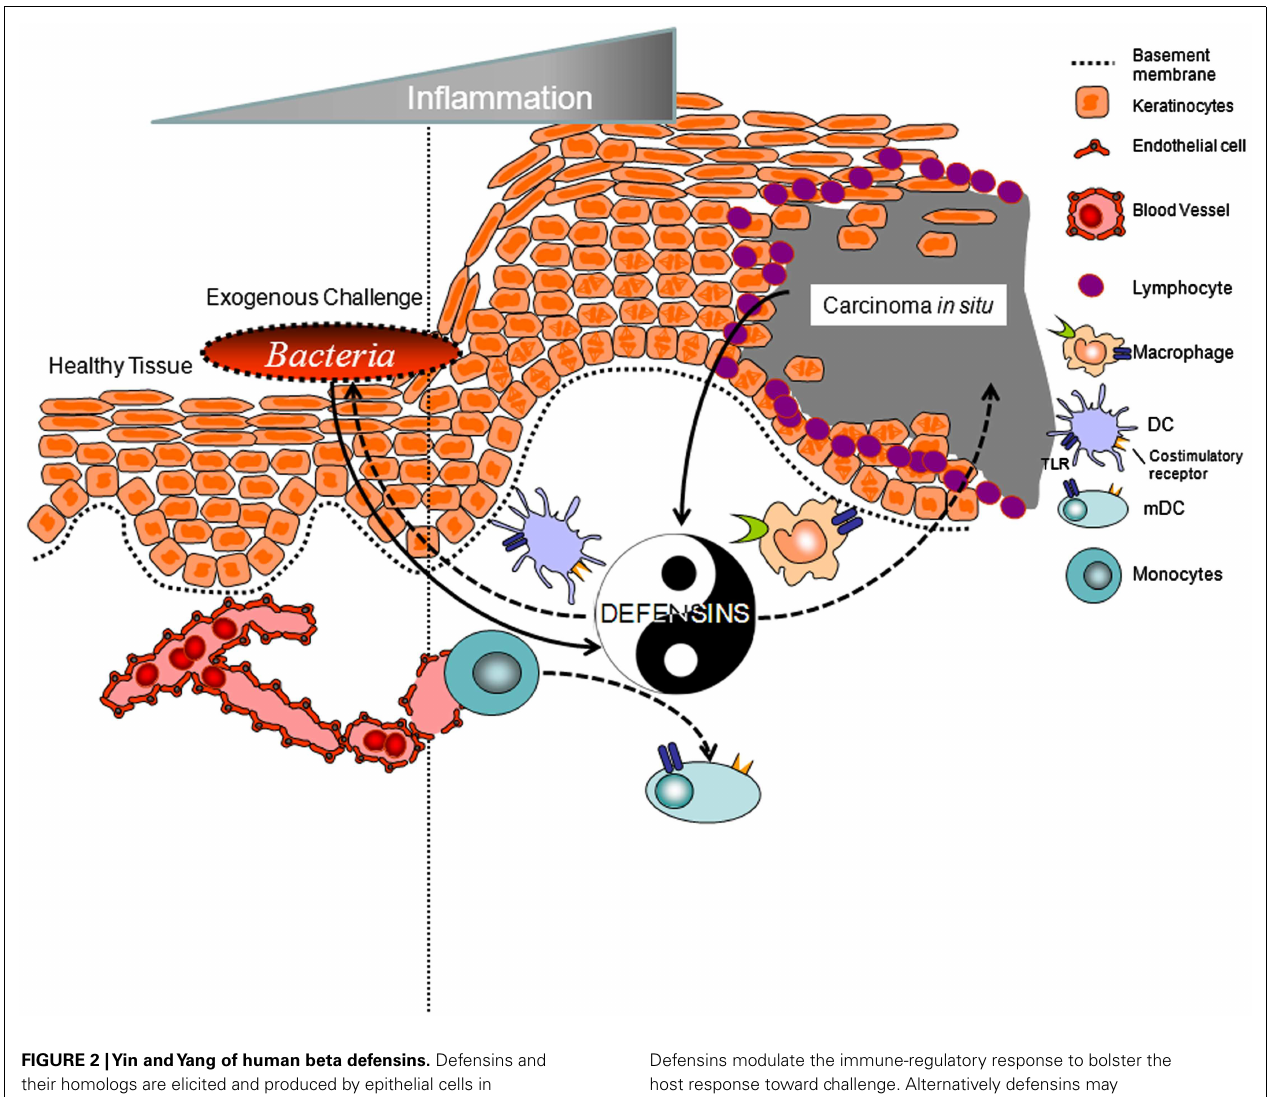
FIGURE 2 |Yin andYang of human beta defensins. Defensins and their homologs are elicited and produced by epithelial cells in response to various stimuli including wounding, bacterial challenge (such as the oral bacteria Fusobacterium nucleatum ; Gupta et al., 2010), or tumor development (Carcinoma in situ , as